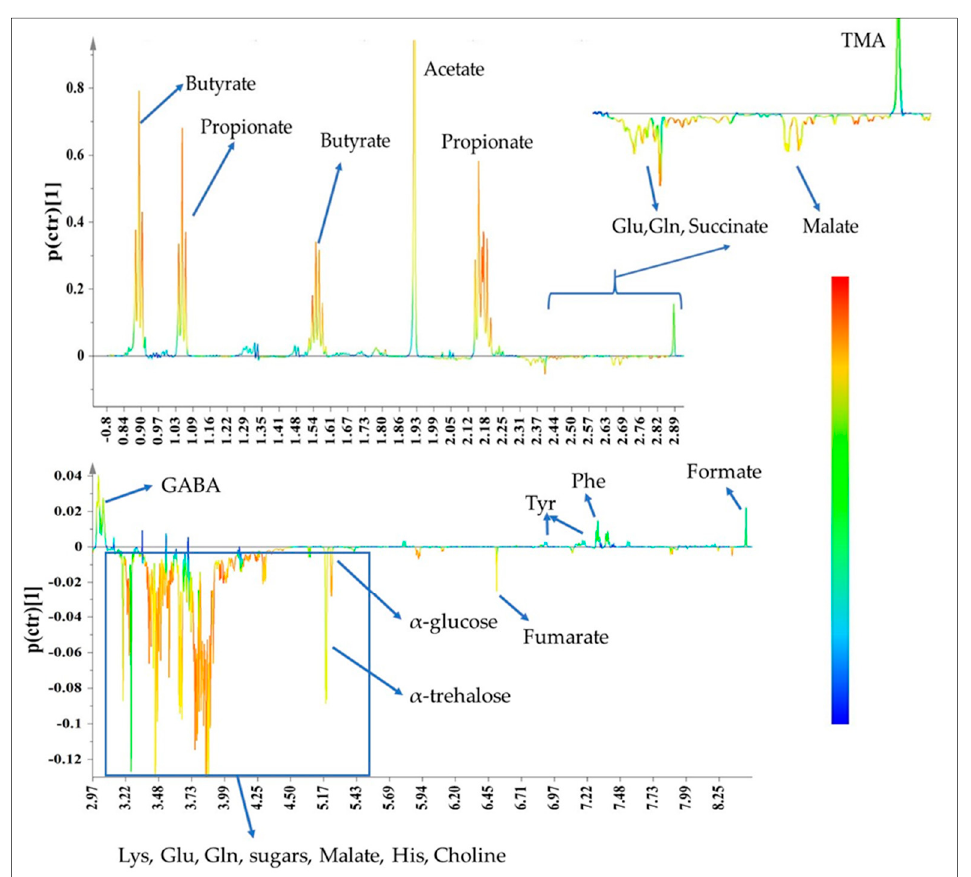
Figure 9. S-line plot based on the OPLS-DA model in order to visualise the most discriminative metabolites. The colour coding corresponds to the significance of their contribution with the red colour depicting the metabolites that most influence the separation of the groups. Resonance lines with positive values correspond to the most characteristic metabolites for the post-fermentation supernatants, and those with negative values constitute the most discriminative for the pre-fermented supernatants. PO: P. ostreatus strain 1123, POL: P. ostreatus strain LGM 22, PE: P. eryngii strain LGAM 216, CC2: C. cylindracea strain CC2, CC505: C. cylindracea strain CC505.